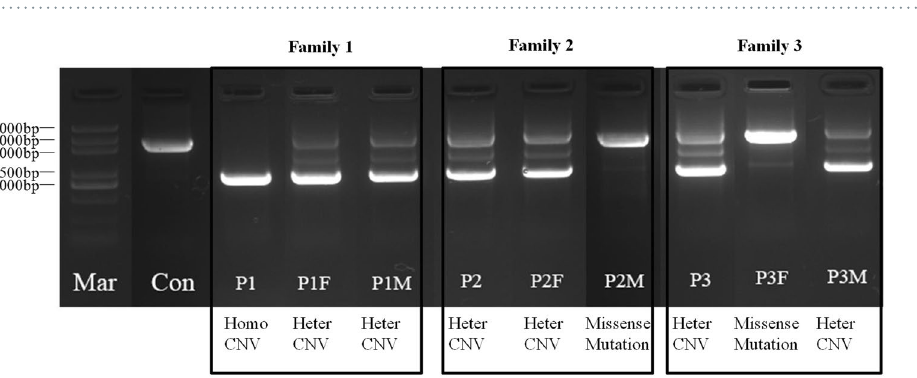
Table 2. Genotype of three MEB patients with POMGNT1 (ENST00000371992, NM_001243766) mutations.